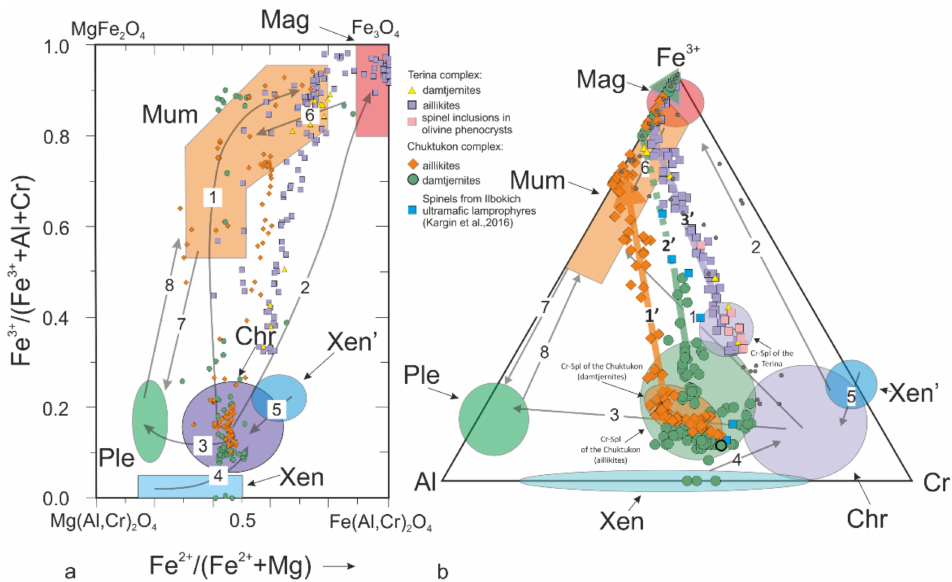
Figure 6. ( a ) Plot of Fe 3+ /(Fe 3+ + Al + Cr) & Fe 2+ /(Fe 2+ + Mg) and ( b ) diagram Al–Fe 3+ -Cr. Xen—spinel xenocrystals from peridotites, Xen’—metasomatized spinel xenocrystal from peridotites, Chl—chromite, Ple—pleonast-spinel, Mum— magnesio-ulvospinel-magnetite and magnetite (Mag). The lines show possible evolutionary trends for different genetic types of spinels [27]. Black circles are the spinels from ultramafic lamphrophyres of Greenland and Canada [43–45].